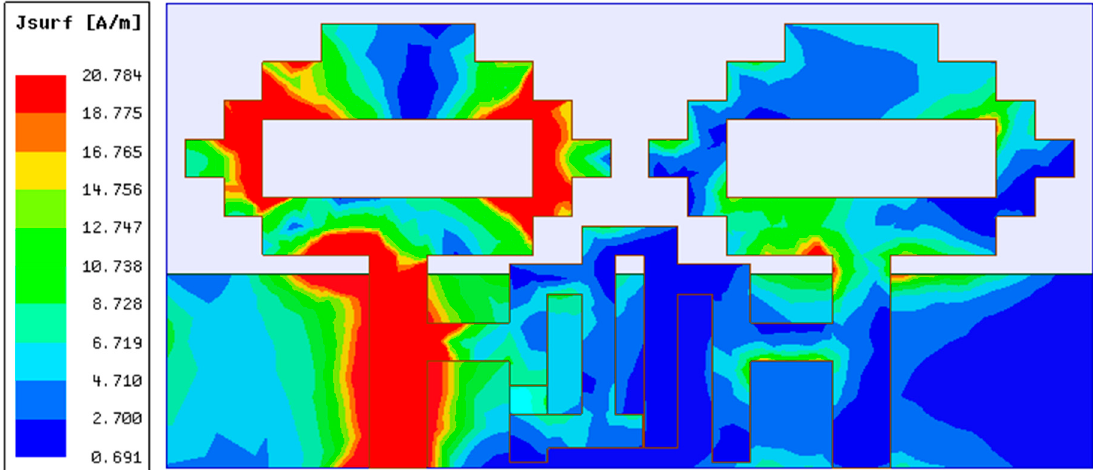
Figure 16. Two-element MIMO antenna surface current distribution at 4.75 GHz.